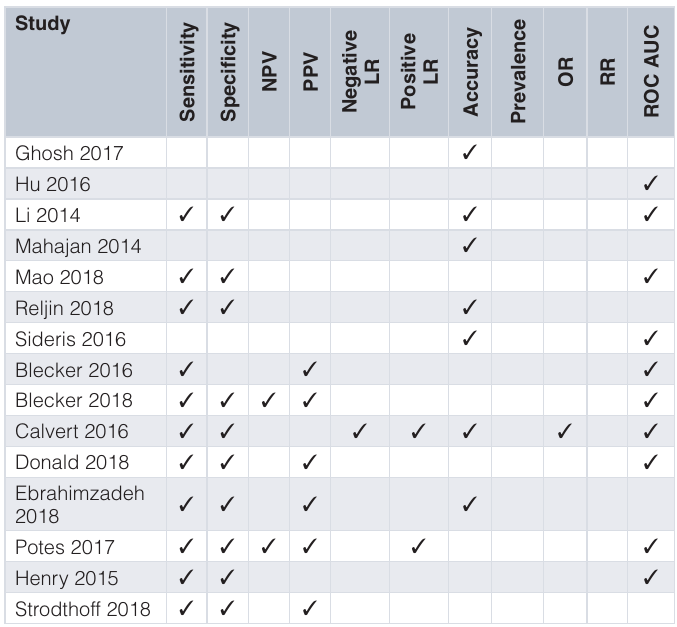
Table 4. Overview of measured outcomes in studies on shock.